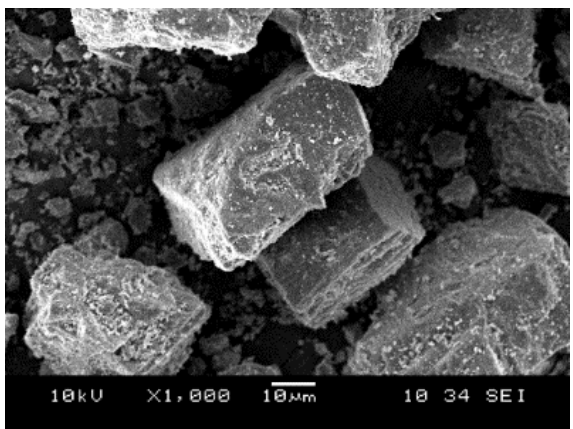
Figure 6. SEM image of raw dolomite particles.